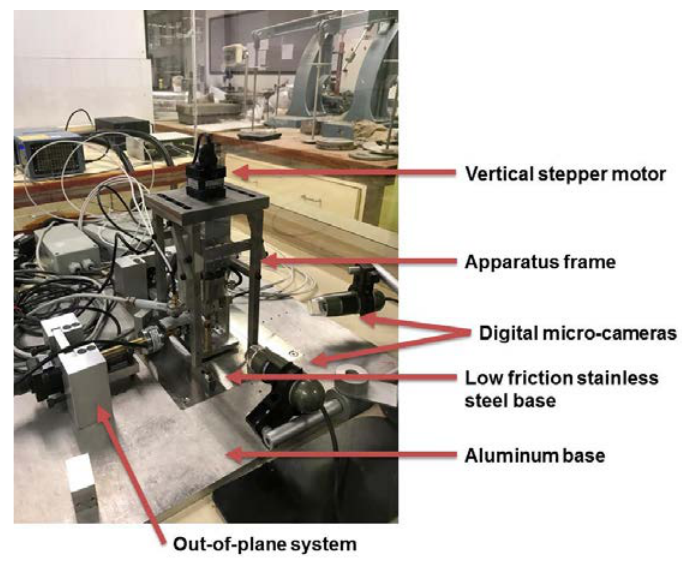
Figure 3. Image of the micromechanical sliding apparatus of City University of Hong Kong.